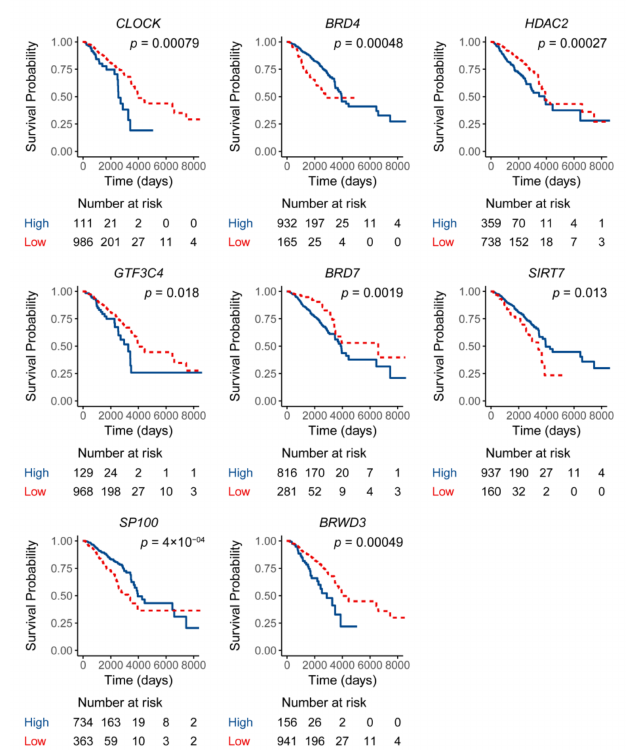
Figure 1. Survival analysis of the eight featured genes. Survival analyses were conducted by Kaplan–Meier method according to the expression level of each specific gene. The optimum cutpoint for distinguishing low and high expression group was determined with the “surv_cutpoint” function.